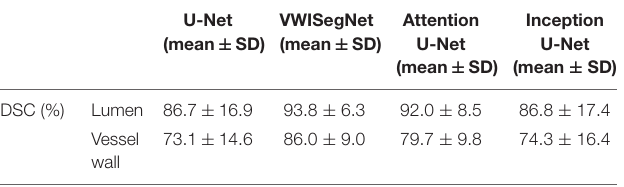
TABLE 1 | The segmentation results for lumen contours and vessel wall contours of different methods.